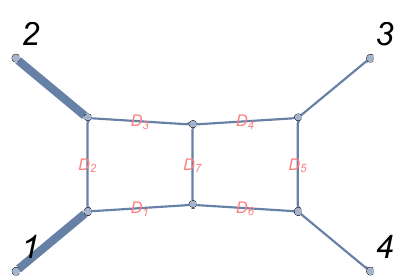
Figure 8 . Double box diagram with two adjacent external massive leg. This graph is produced by the package Azurite